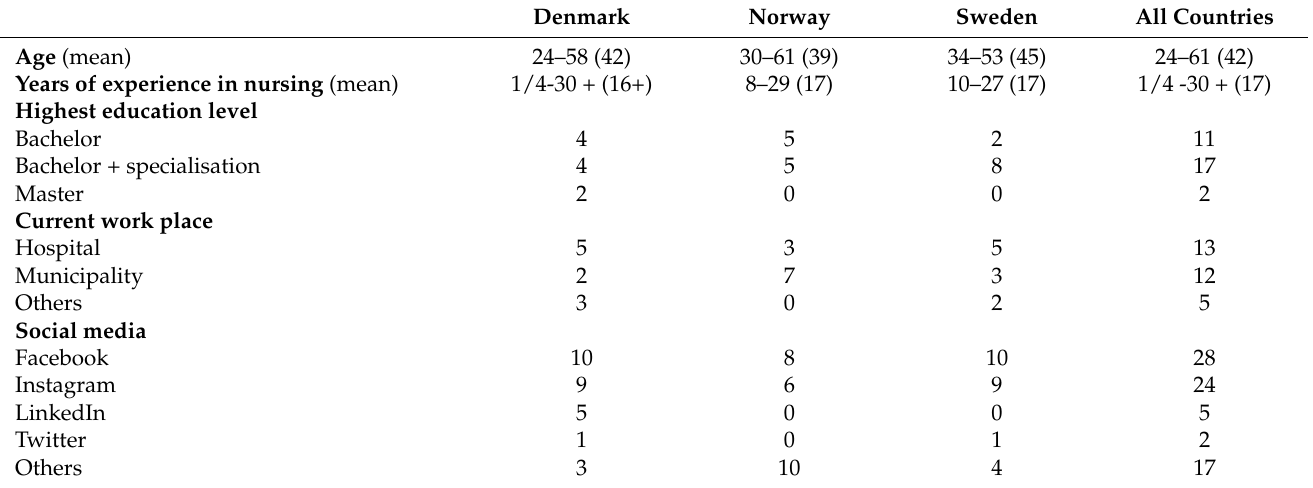
Table 1. Description of the